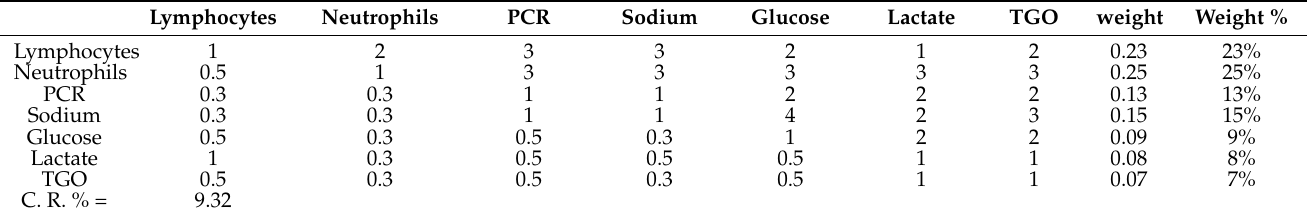
Table 5. Decision matrix and weights computation for Level 3 subcriteria derived from blood test criteria.